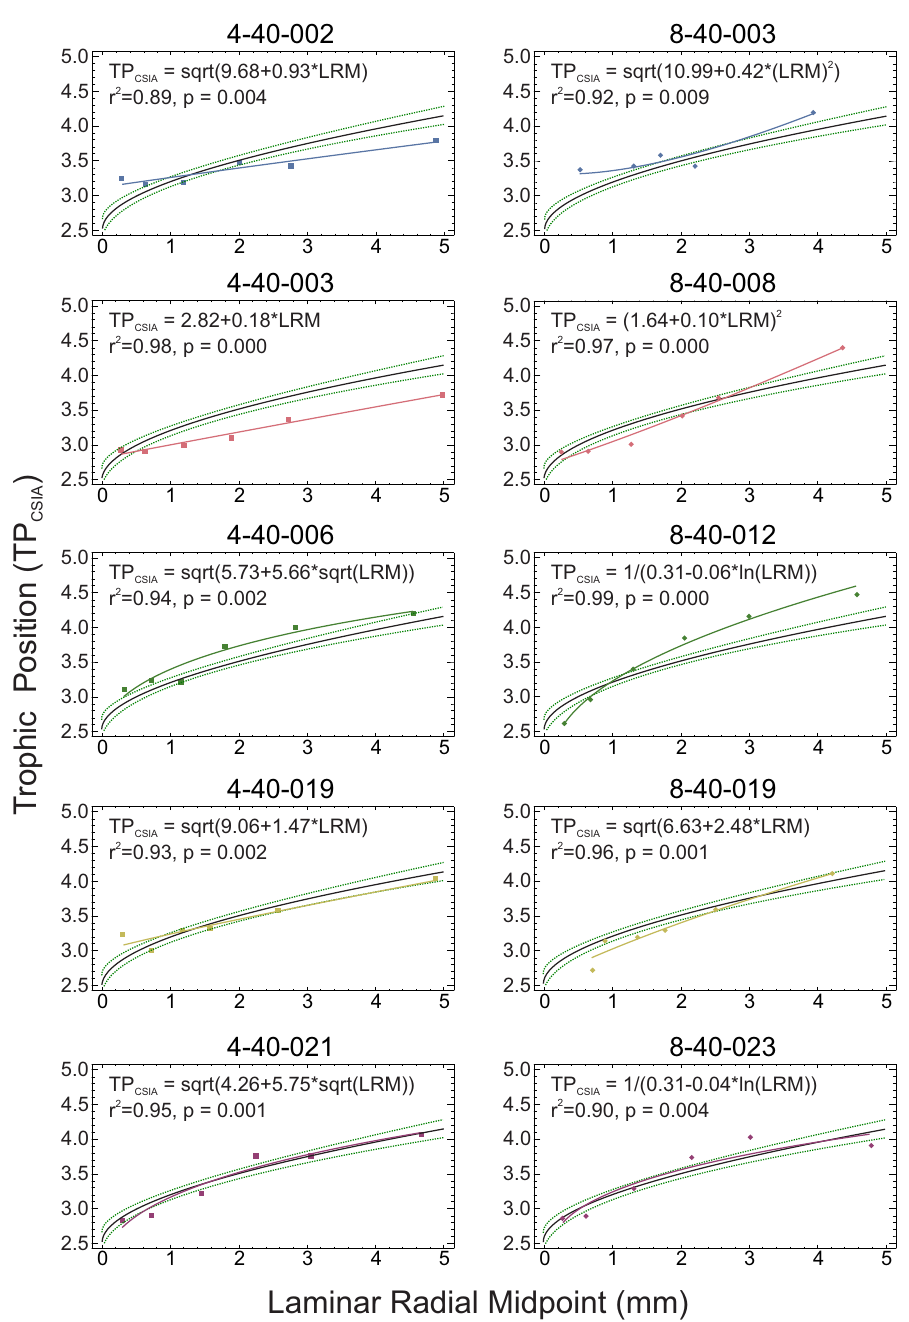
Fig 3. Comparison of composite trophic trajectory model with individual trophic trajectory models. The squares and circles are TP CSIA for individual laminae, colored solid line is the individual model, black solid line is the composite model calculated using all TP CSIA values, and green dotted lines are the 95% confidence intervals for predicted means of the composite model is TP CSIA = (1.587 + 0.201 � sqrt(LRM)) 2 , n = 60, R 2 = 0.77, p < 0.0001.